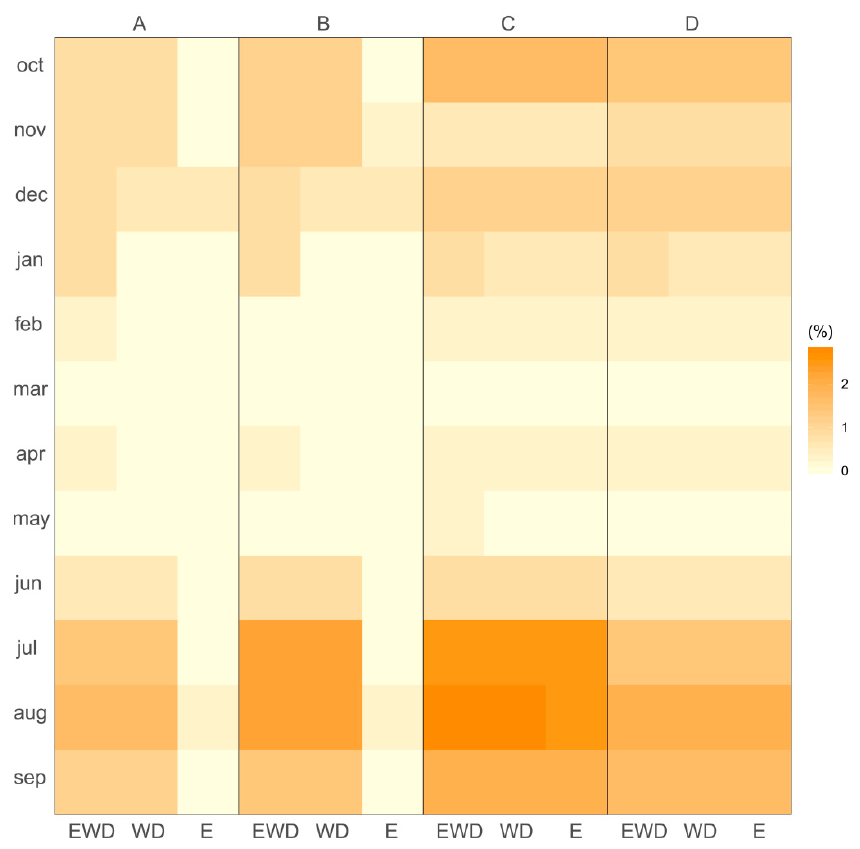
Figure 15. Mean monthly percentage where the different water demands (EWD, WD, and E) are not met in the established strategies (A, B, C, and D).